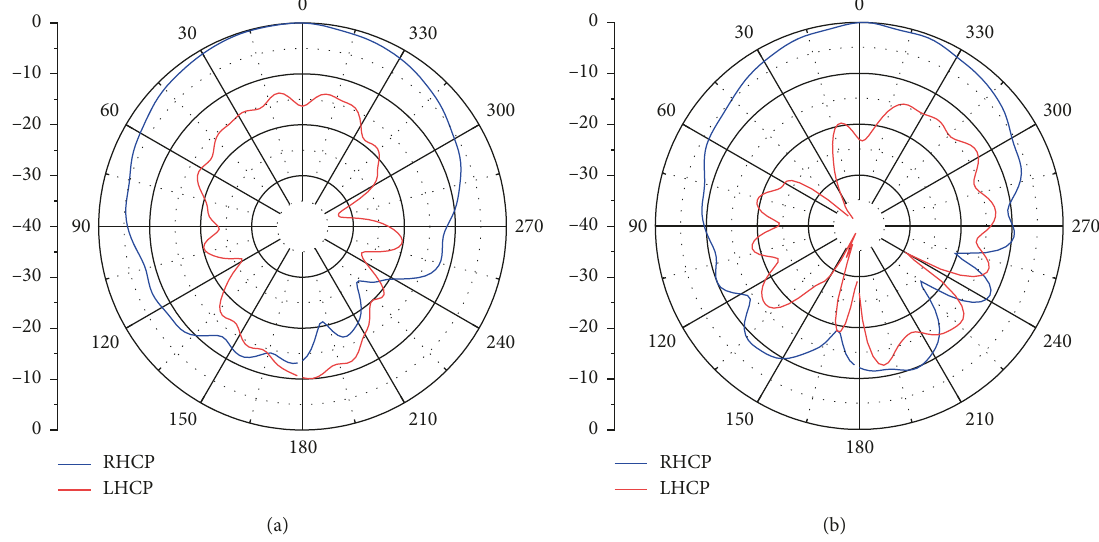
Figure 10: Measured radiation patterns of the proposed antenna at (a) 1.225GHz and (b) 1.582GHz.